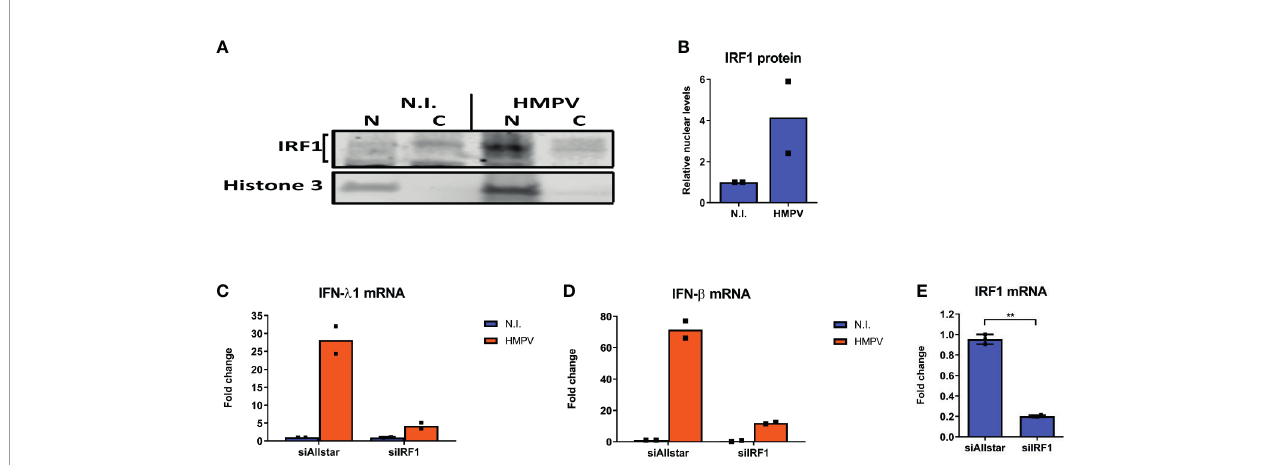
FIGURE 2 | HMPV stimulates IRF1 nuclear translocation and IRF1-dependent IFN- l induction. (A, B) Human MDMs were infected with HMPV for 18 h. Nuclear and cytosolic cell lysates were prepared and protein levels of IRF1 and histone 3 analyzed by immunoblotting. Changes in nuclear IRF1 protein level are presented relative to the respective cytosolic levels and to histone 3 levels (B) . (C-E) Human MDMs were transfected with IRF1 siRNA or control siRNA («Allstar») for 48h prior to infection with HMPV for 24 h and analysis of mRNA expression of IFN- l 1 (C) , IFN- b (D) and IRF1 (E) by qRT-PCR. Statistical analysis: Two-way ANOVA